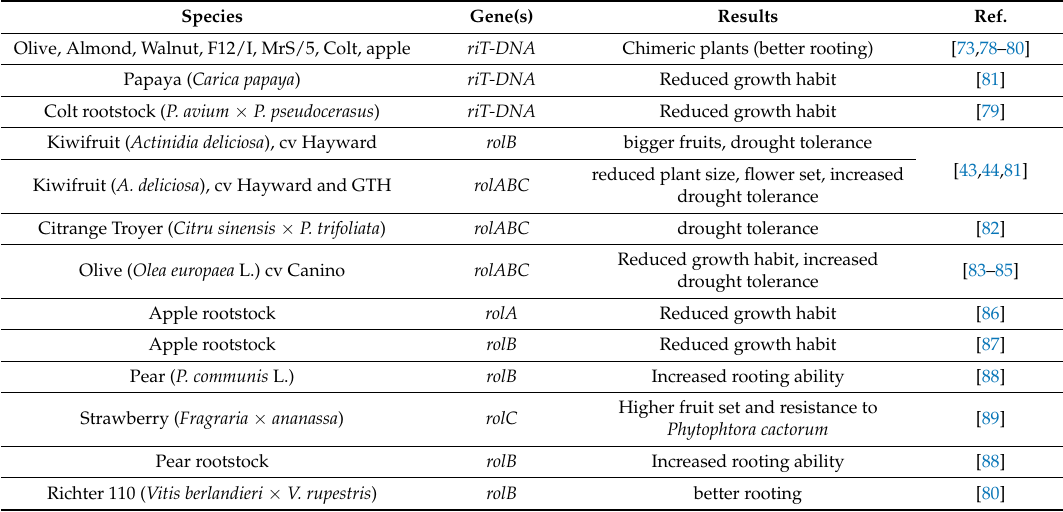
Table 1. Main results in woody fruit species obtained by the use of riT-DNA and rol genes of Agrobacterium rhizogenes . Species Gene(s) Results